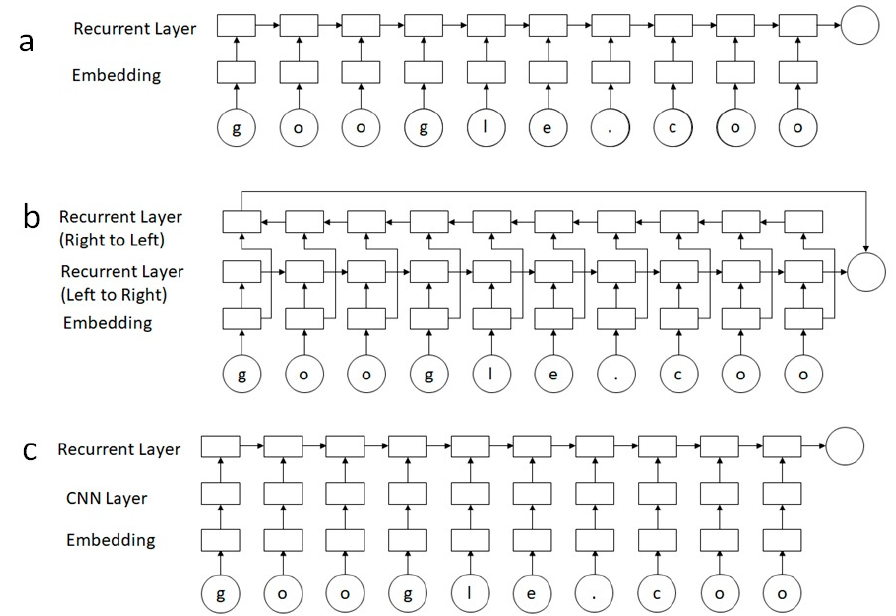
Figure 3. ( a ) A recurrent neural network (RNN) with an embedding layer, ( b ) a bidirectional RNN with an embedding layer, ( c ) an RNN with an embedding layer and a Convolutional Neural Networks (CNN) layer.